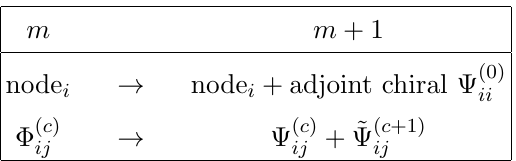
Figure 1. Toric diagrams for C m +2 with m = 0 ; 1 ;